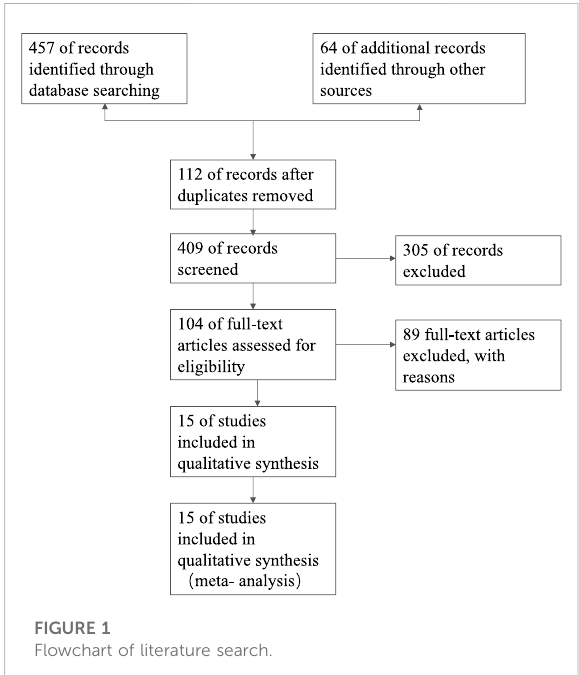
FIGURE 1 Flowchart of literature